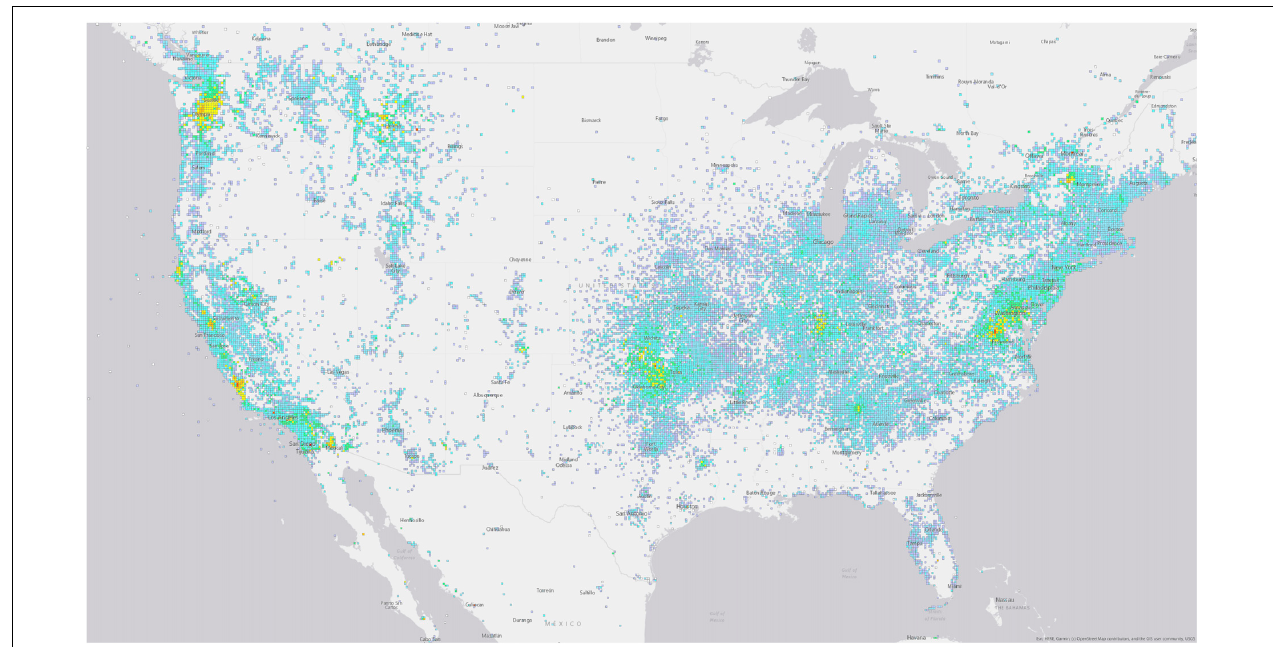
FIGURE 7 | Cumulative maximum DYFI intensities, 10-km geocoded blocks, in the U.S. from 1999 through 2018. Each cell is a 10-km block. Color corresponds to the highest intensity reported in that block among all events in that timespan using the intensity scale shown in Figure 1 . This map and intensity maps for each year are available online in the Summary Maps section of the DYFI website (Source: U.S. Geological